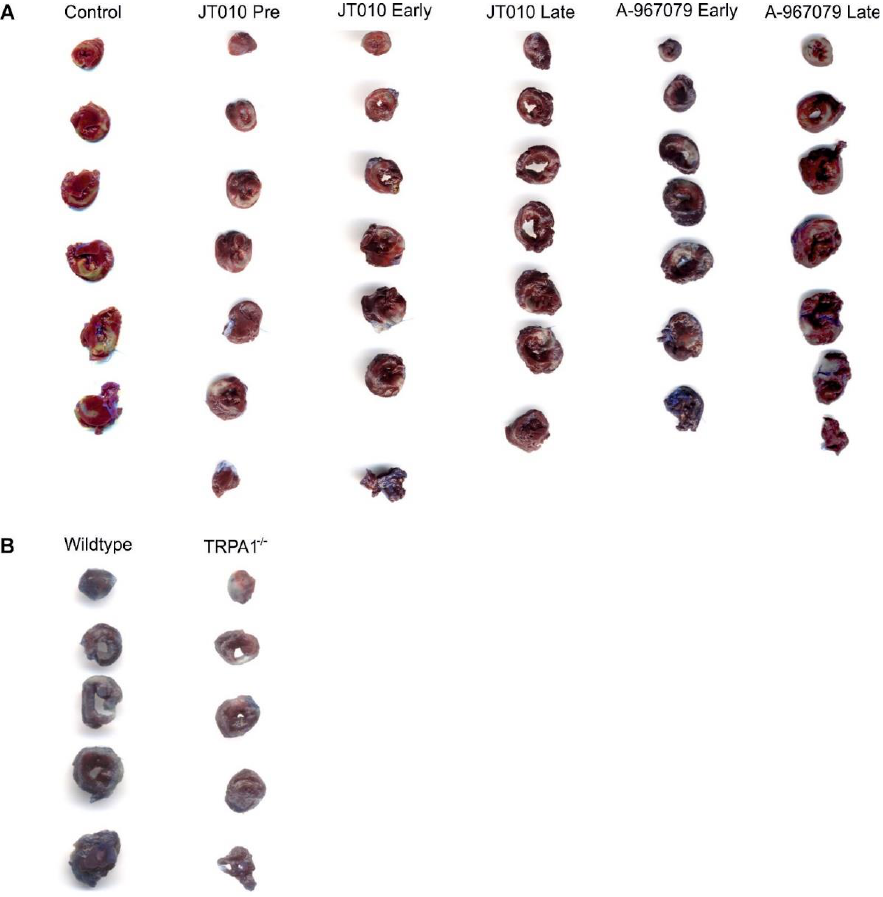
Figure A1. Representative images of staining for area at risk and infarct size. Myocardial infarction analysis by triphenyltetrazolium chloride staining. Representative images are provided for ( A ) rats and ( B ) mice.